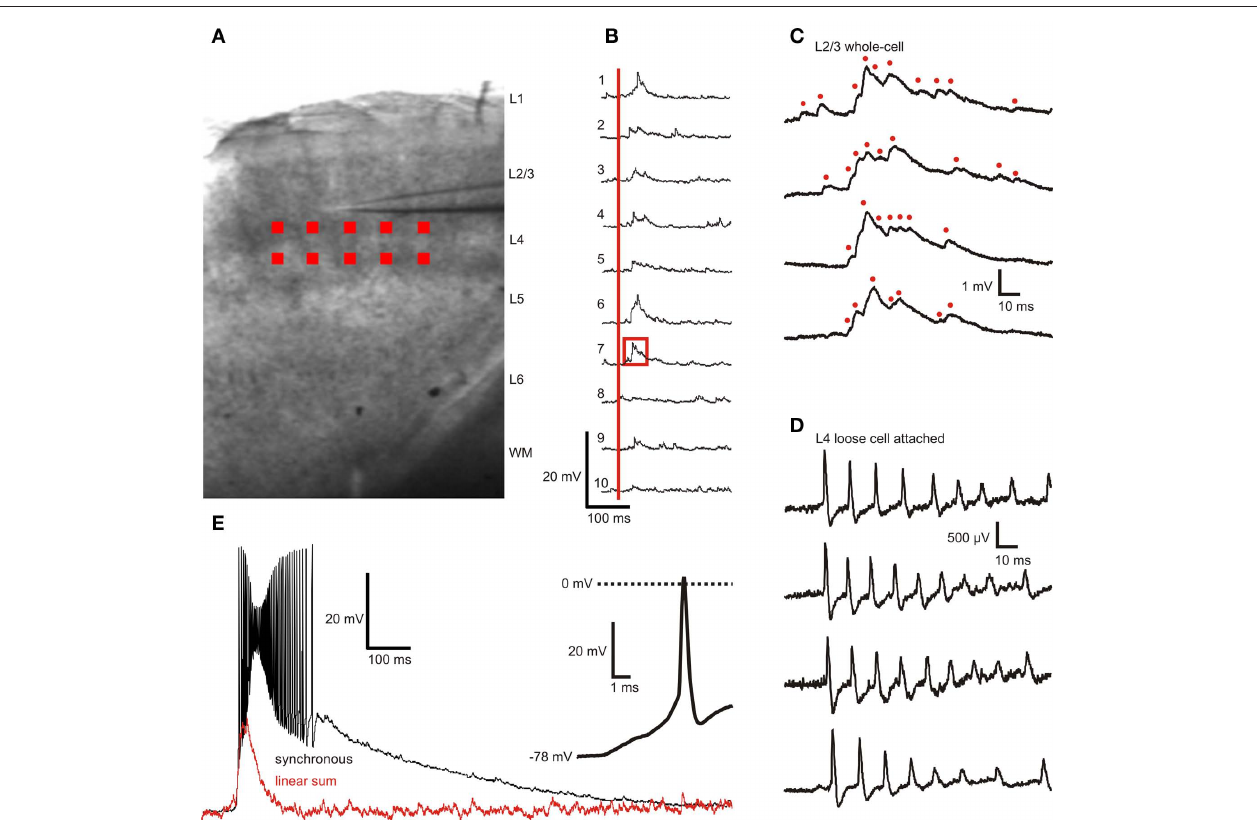
Presumed single or compound EPSPs are marked with red dots. (D) L4 spiking responses to direct somatic photostimulation showing that each stimulus typically elicits multiple action potentials. The time window relative to photostimulation is identical to that in (C,e) Supralinear L2/3 membrane potential responses to activation of all 10 sites with perfect synchrony. Red trace represents the linear sum of the individual responses shown in (B) . Inset shows expanded view of the first spike in the burst of response spikes. Bath concentration of caged Glu was